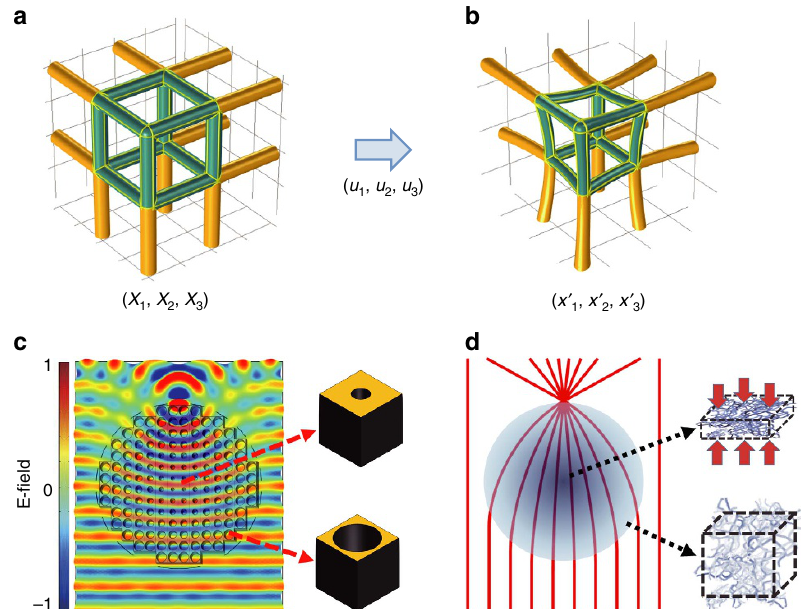
Figure 1 | Concept diagrams of an elasto-optic metamaterial and a Luneburg lens. ( a , b ) Deformation of the elasto-optic metamaterial. The coordinate transformation from ( X 1 , X 2 , X 3 ) to ( x 0 1 , x 0 2 , x 0 3 ) by elastic deformation of displacement ( u 1 , u 2 , u 3 ) in a network structure of an elasto-optic metamaterial. The green rods in the cube indicate a unit cell of the network structure made of incompressible dielectric materials with an air void. Elastic deformation squeezes the unit cell and the volume of the void, thereby causing changes of the volume fraction between the dielectric and the void and thus the effective index. ( c ) Electric field distribution and a schematic of a Luneburg lens made with conventional metamaterials of the same sized unit cells with different hole geometries. Because of the difficult fabrication process used, the light-controlling volume is o 10 l (cid:2) 10 l (cid:2) 10 l . ( d ) A schematic of a Luneburg lens made with an elasto-optic metamaterial mechanically deformed from a homogeneous nanoporous material. Using a simple elastic deformation process, the light-controlling volume is 4 10 5 l (cid:2) 10 5 l (cid:2) 10 3 l